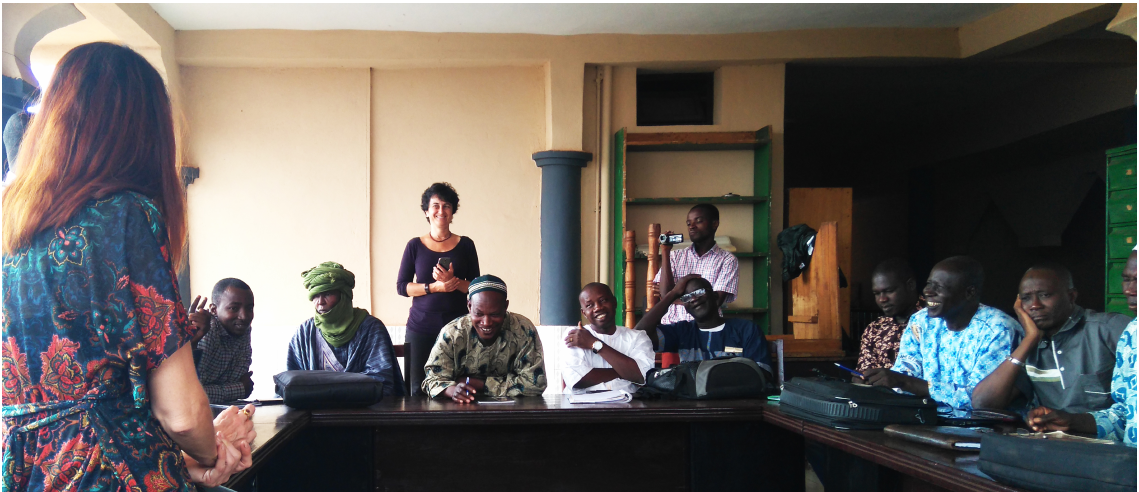
Figure 4. Assessment of information needs, by farmers during one of our workshops in Bamako,